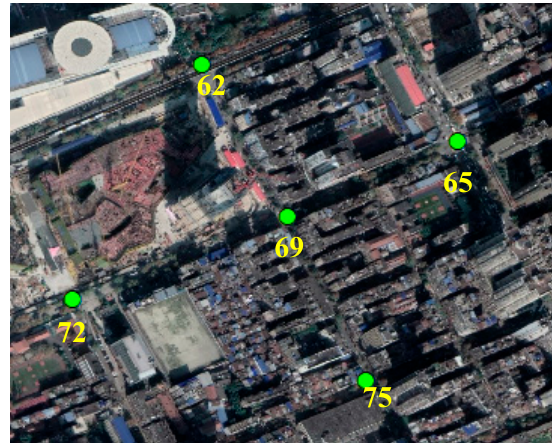
Figure 17. The final road network extraction results: ( a ) results of road network detection in Wuhan; ( b ) results of road network detection in Chicago.